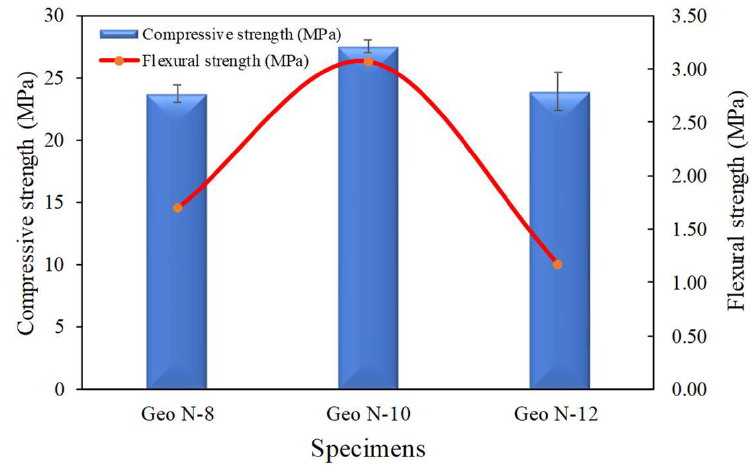
Figure 7. Compressive strength and flexural strength of geopolymer paste.